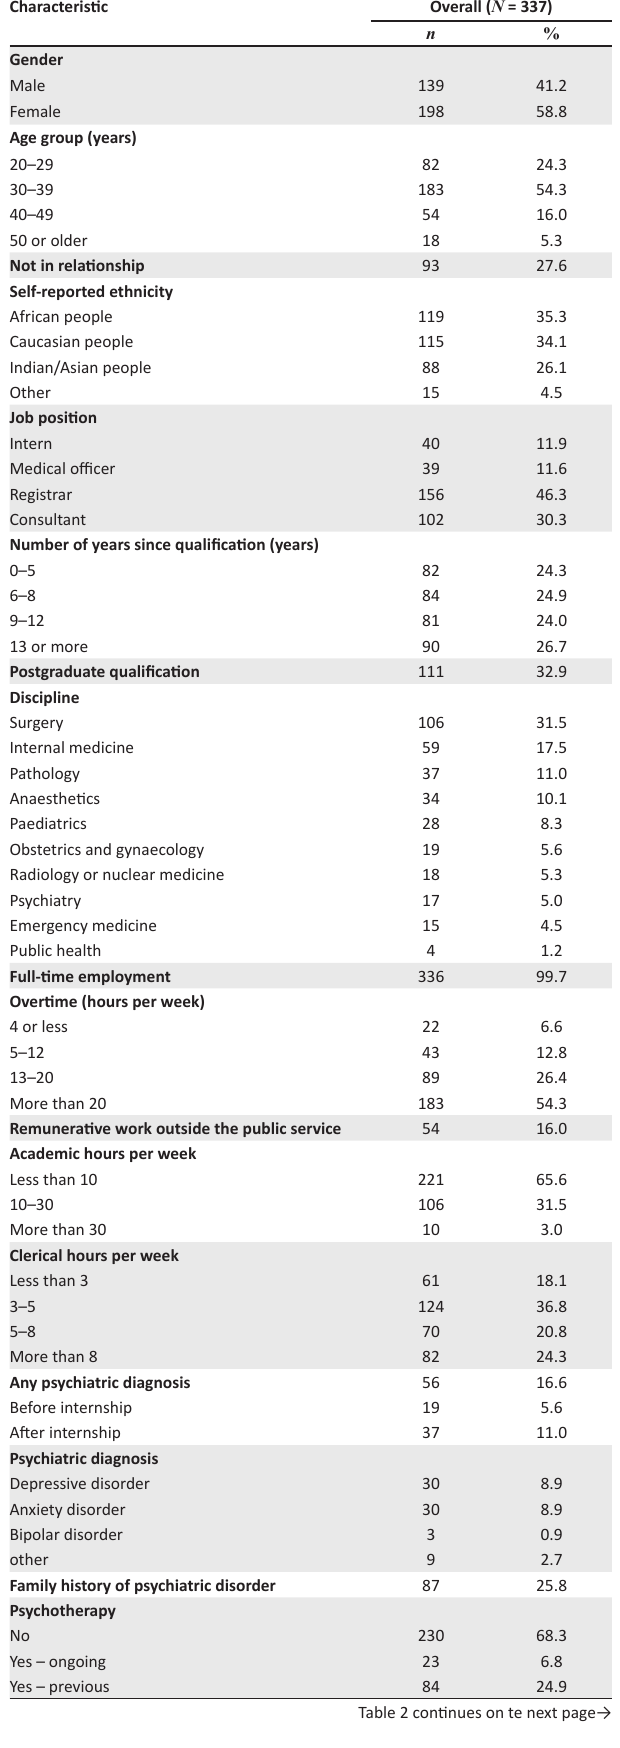
TABLE 2: Characteristics of the study